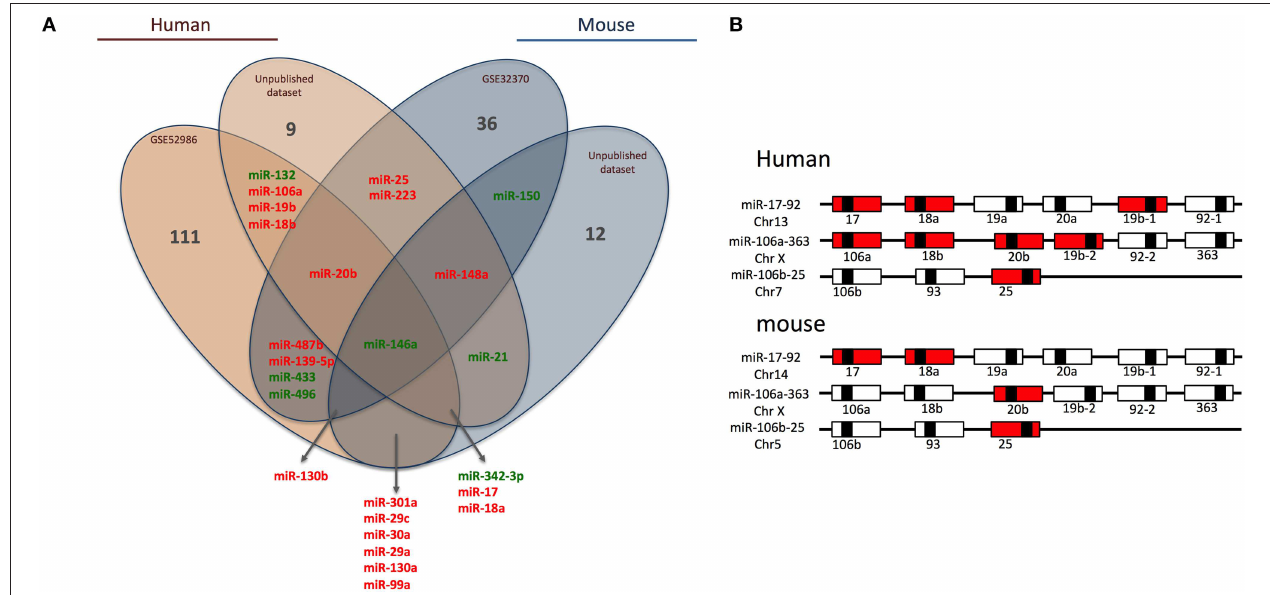
FIGURE 1 | Human and mouse miRNome profiles identifying monocyte subset-specific miRNAs. (A) Four datasets were analyzed and clustered to obtain a Venn diagram showing miRNAs differentially regulated between classical and non-classical monocytes and common to human and mouse. Red and green represent miRNAs up- and down-regulated, respectively, in classical vs. non-classical monocytes. (B) Schematic representation of members of the miR-17/92 family of miRNA gene clusters in human and mouse. MiRNAs upregulated in classical monocytes vs. non-classical monocytes are in